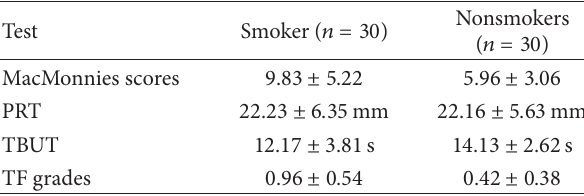
Table 1: The mean ± SD for MacMonnies scores, PRT test, TBUT test, and TF grades for smoker and nonsmoker subjects.